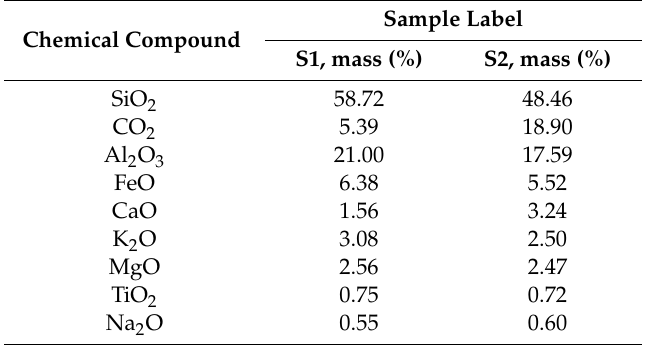
Table 2. Chemical composition of two raw materials expressed in oxide form.